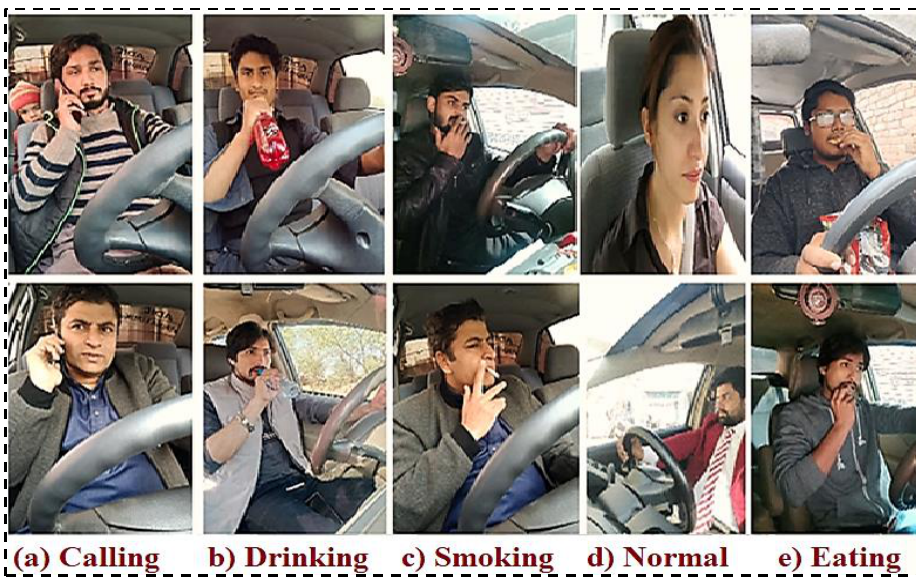
Sensors 2023 , 23 , x FOR PEER REVIEW Figure 2. Keyframes for Unusual Activities of Driver. Figure 2. Keyframes for Unusual Activities of Driver.